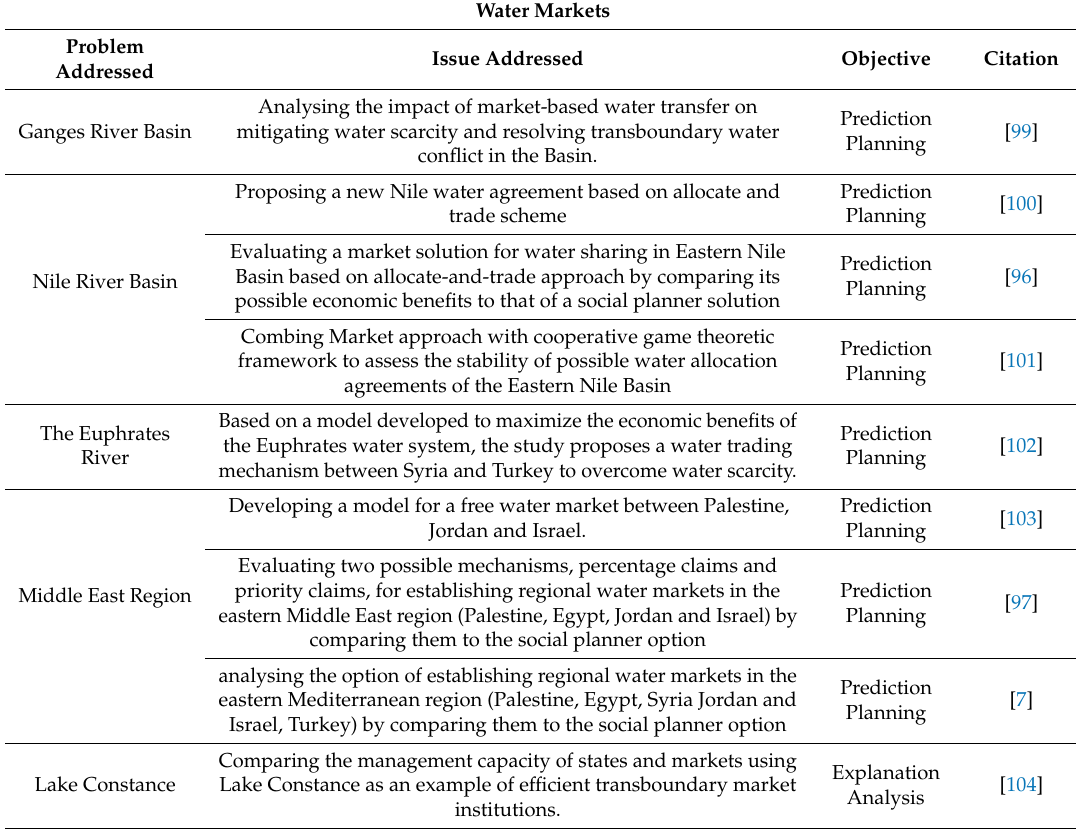
Table 4. Market Mechanism—Theory and